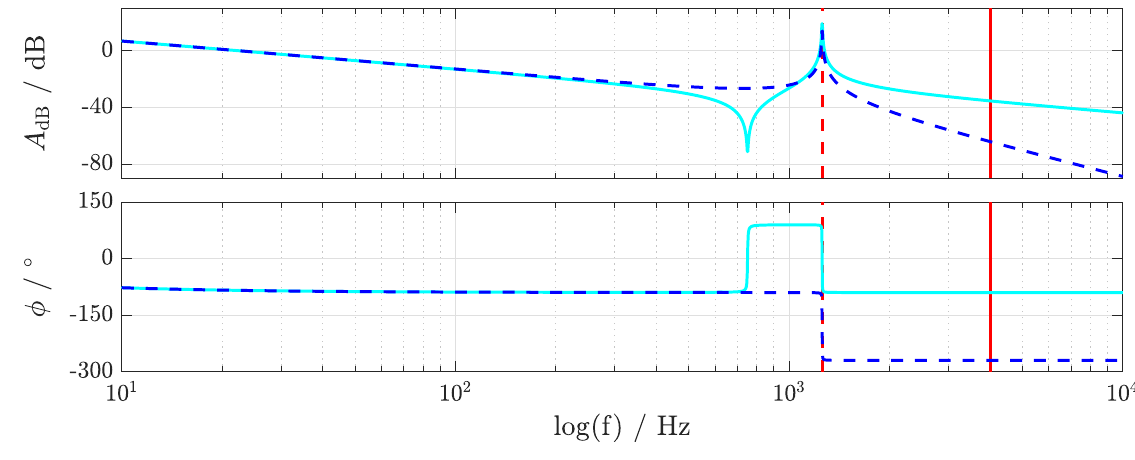
Figure 2. Bode plot of the LCL filter for different system outputs while cross-coupling terms are neglected. [Color